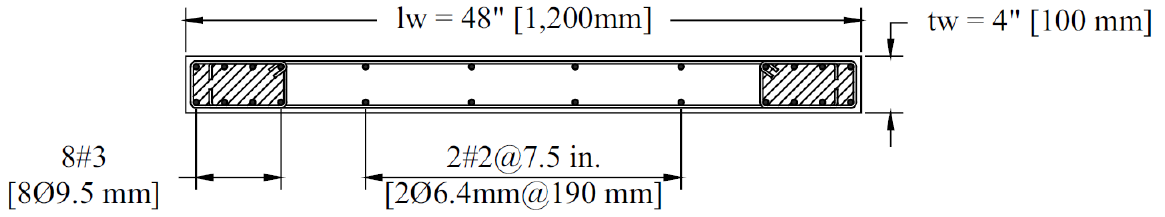
Figure 2. Reinforcing details of Specimen RW2 [21]. The OpenSees material Concrete01 [13] was used to model concrete, considering the actual compressive strength instead of the nominal value. The strain at the peak stress was considered to be 0.002, the concrete’s crushing strength was taken to be 20% of the actual compressive strength, and the ultimate strain was taken to be 0.008, as recommended by Pugh et al. [22]. The confined concrete parameters were obtained from the